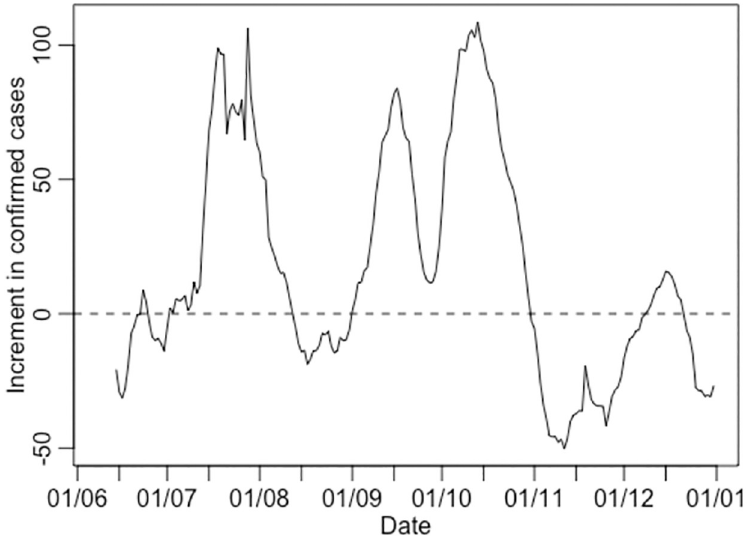
Fig 1. Increment function of COVID-19 confirmed cases. The % increase or decrease in the rolling seven-day sum of the number of cases is relative to the immediately preceding seven-day period. The curve starts on June 1, 2020 and runs through the end of